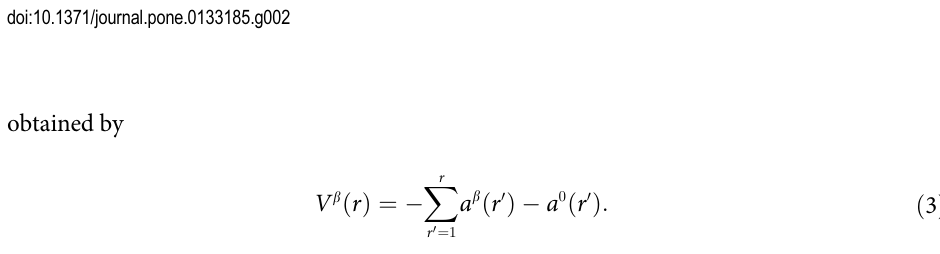
Fig 2. Probability of interactions of type β , P b i as a function of the distance r between players. An approximate power law exponent for communication events is found to be * − 1.3 (black